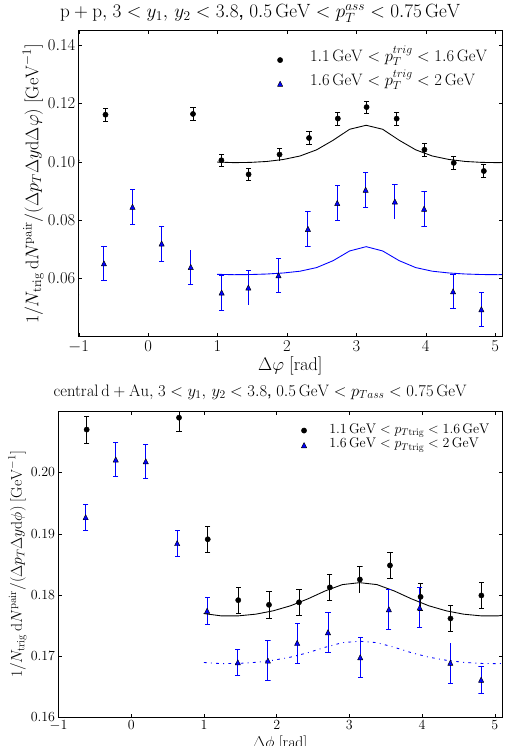
Figure 23. Azimuthal correlation for π 0 production compared to PHENIX data [151]. ( Top ) Proton– proton collision. ( Bottom ) Central deuteron–gold collisions. Figures from the works in [148,152]. More modern version of this work both experimentally [150] and theoretically exist with forthcoming